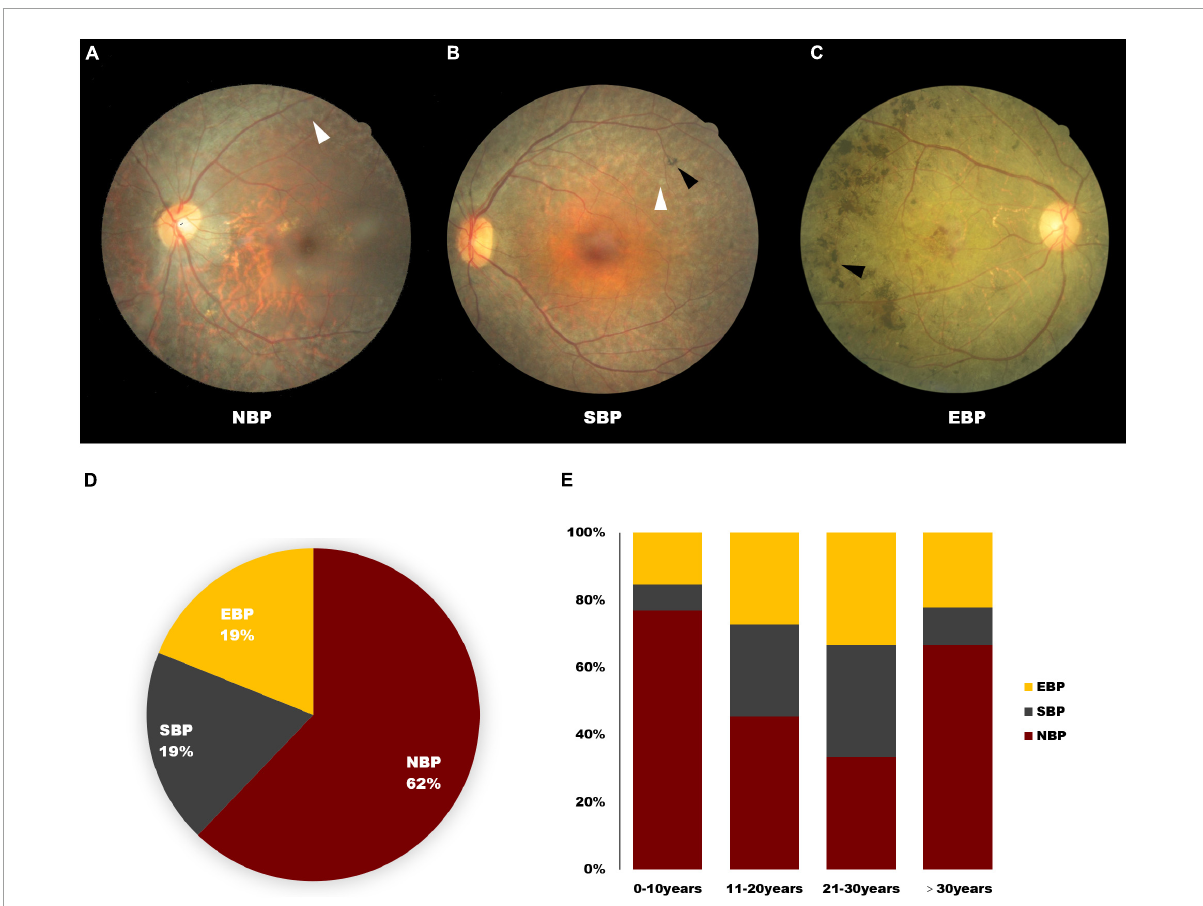
FIGURE1 Clinical manifestations of USH2A -related inherited retinal dystrophy (IRD) patients. (A–C) Fundus photos present no bone-spicule pigmentation (NBP), scattered bone spicule (SBP), and extensive bone-spicule (EBP) in the posterior pole of the fundus. The black arrowheads indicate the bone-spicule pigmentation, white arrowheads indicated the RPE depigmentation presenting as small pale patches. (D,E) Distribution of USH2A -related IRDs patients presenting as NBP, SBP, and EBP. The X-axis of E represents the disease duration of < 10, 11–20, 21–30, and > 30